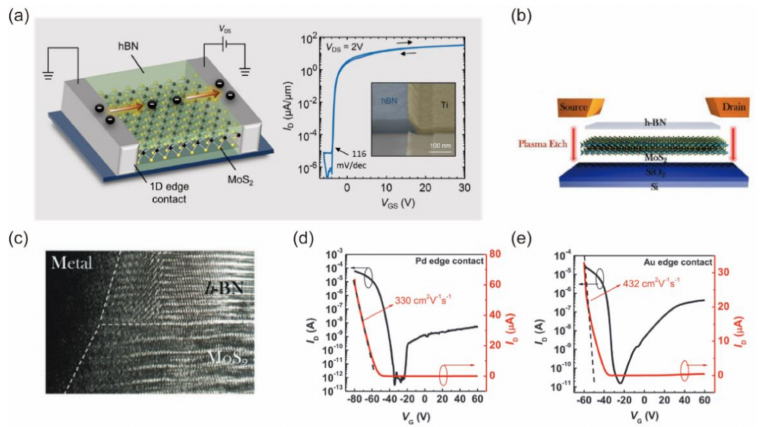
Figure 5. ( a ) Schematic of 1D edge contact MoS 2 FET and transfer curve. Reprinted/adapted with permission from Ref. [56]. Copyright 2019, American Chemical Society. ( b ) Schematic diagram shows 1D edge contact FET with different metals. ( c ) HR − TEM image of Pd − MoS 2 1D edge contact FET; transfer curves of Pd ( d ) and Au ( e ) edge contact MoS 2 FETs, realizing p-type intrinsic MoS 2 FETs and Fermi-level depinning. Reprinted/adapted with permission from Ref. [55]. Copyright 2019, John Wiley and